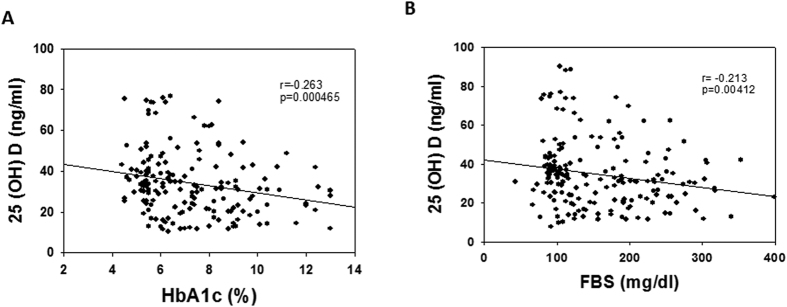
Scatterplot representing relationship between (A) 25(OH)D and FBS (B) 25(OH)D and HbA1C.